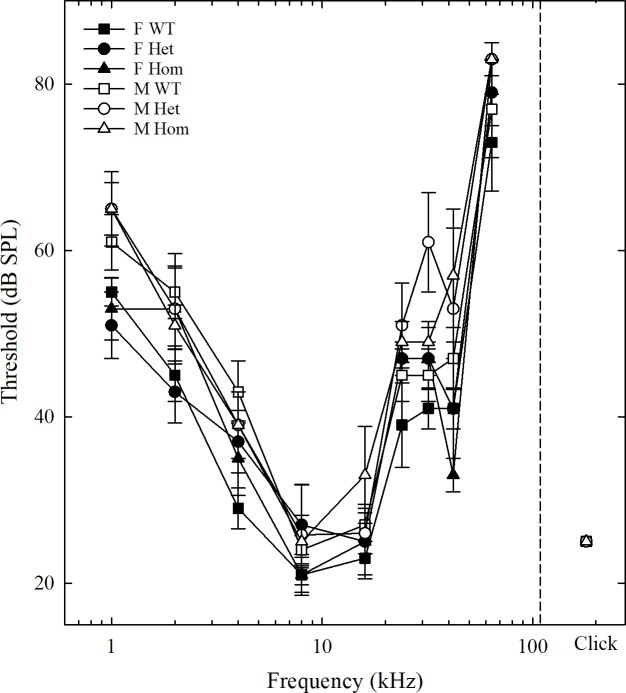
Auditory brainstem thresholds across genotype and sex.Mean ABR thresholds for each genotype and sex for tones ranging from 1 to 64 kHz and clicks. Error bars are standard error of the mean (Males = white fill, Females = black fill, wild-type = squares, heterozygotes = circles, and Brattleboro homozygotes = triangles).